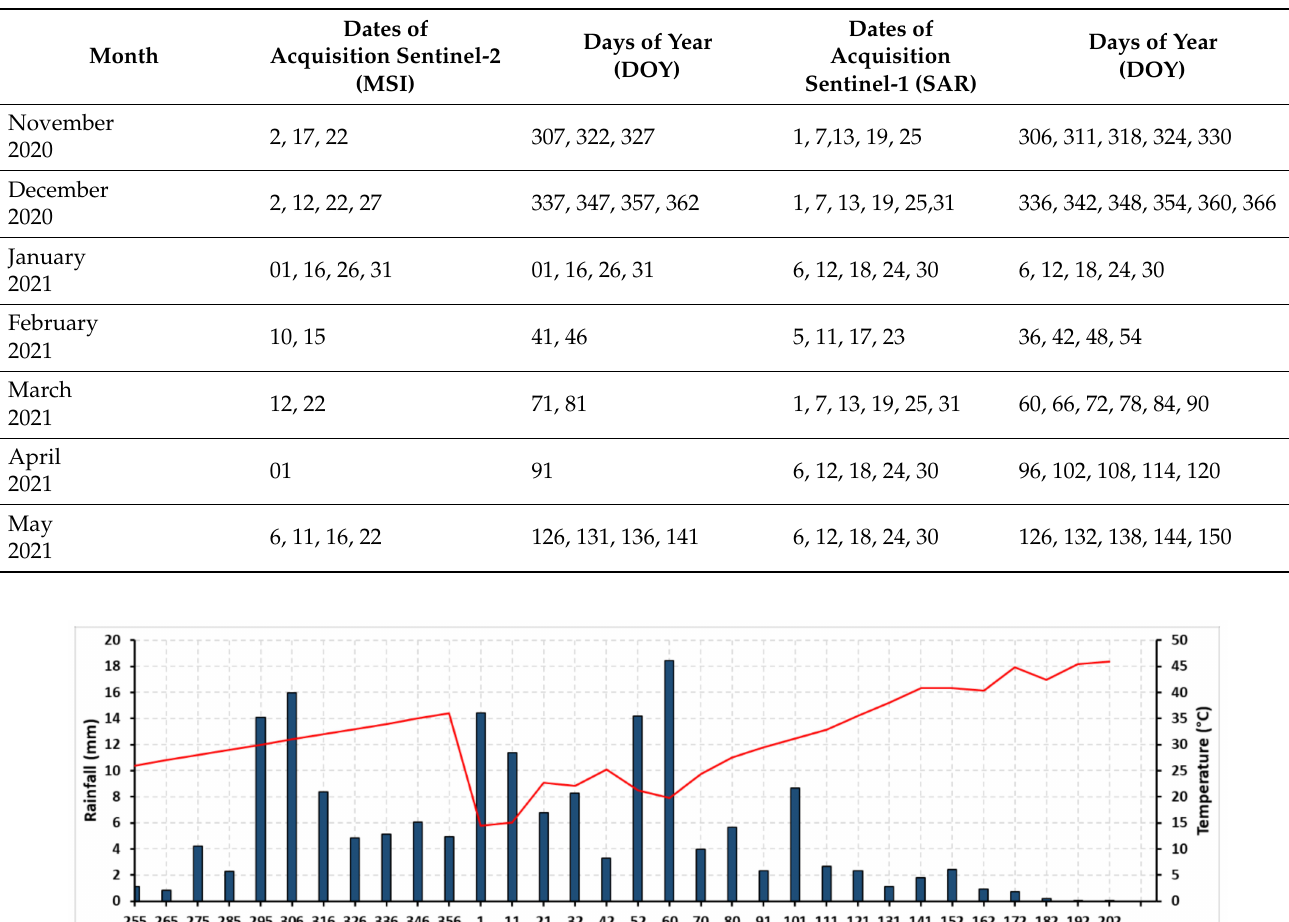
Table 3. Sentinel-1 and Sentinel-2 acquisition dates.